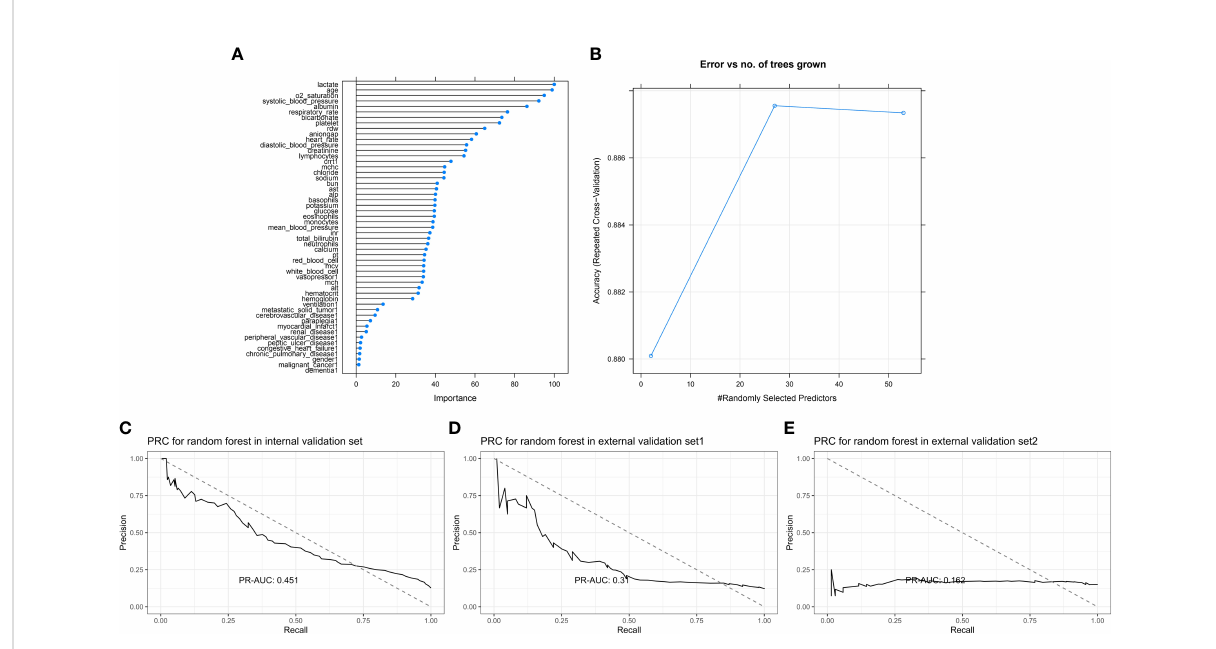
FIGURE 6 Feature importance score plot of random forest (A) . Model accuracy of random forest in fl uenced by different number of randomly selected predictors (B) . PR-AUC for random forest in the internal validation set, the external validation set 1, and the external validation set 2 [from (C – E)